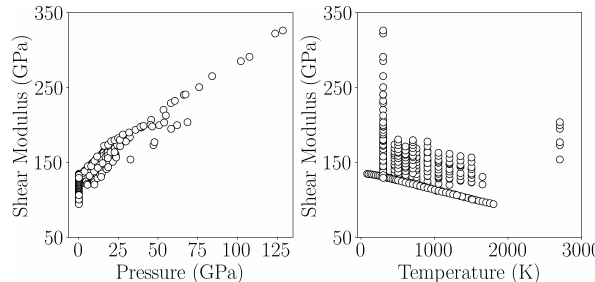
Figure 1. Experimental MgO P – G – T data used in this study are collected from Sangster et al. (1970), Sumino et al. (1983), Isaak et al. (1989), Sinogeikin et al. (2000), Sinogeikin and Bass (2000), Zha et al. (2000), Jacobsen et al. (2002), Li et al. (2006), Fukui et al. (2008), Murakami et al. (2009), Kono et al. (2010), Murakami et al. (2012), Finkelstein et al. (2018), and Fan et al. (2019). Note uncertainties in collected experimental data are not plotted because most of them are smaller than the size of the plotting symbol. There are 311 data points in total, and we generate a dataset to train the neural networks by sampling from the uncertainty ranges of these